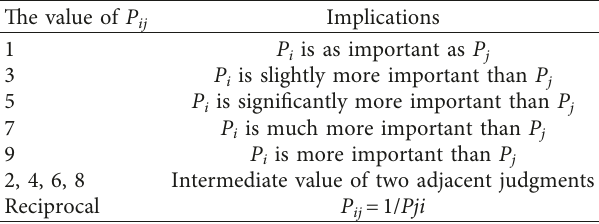
Table 4: Value of random consistency index of n-order matrix.